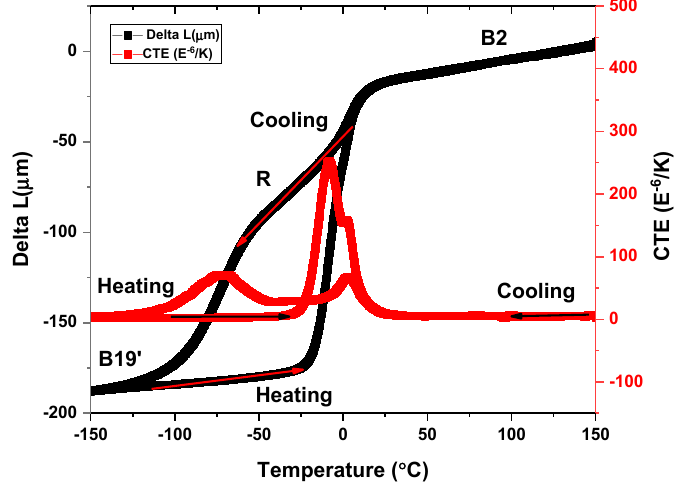
Figure 7. Thermomechanical analysis (TMA) curves of the Ni-Ti ribbon showing displacement ( L ) and the coefficient of thermal expansion (CTE) versus the temperature profile.